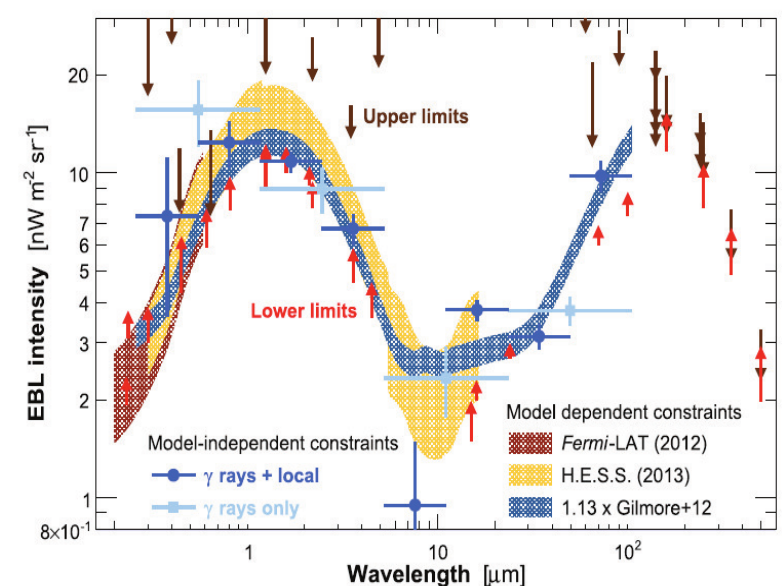
Figure 3. EBL intensity at z = 0 from the analysis of Biteau & Williams [7]. The best-fit spectra derived there are shown with light blue (gamma rays only, four point spectrum) and blue points (gamma rays + direct constraints, eight-point spectrum) based on best-fit scaled-up models by [77,85], 1 σ confidence. Lower and upper limits are shown with orange upward-going and dark-brown downward-going arrows, respectively. The results by [47] and the H.E.S.S. Collaboration (2013) are shown for comparison. (Kind permission by Biteau & Williams